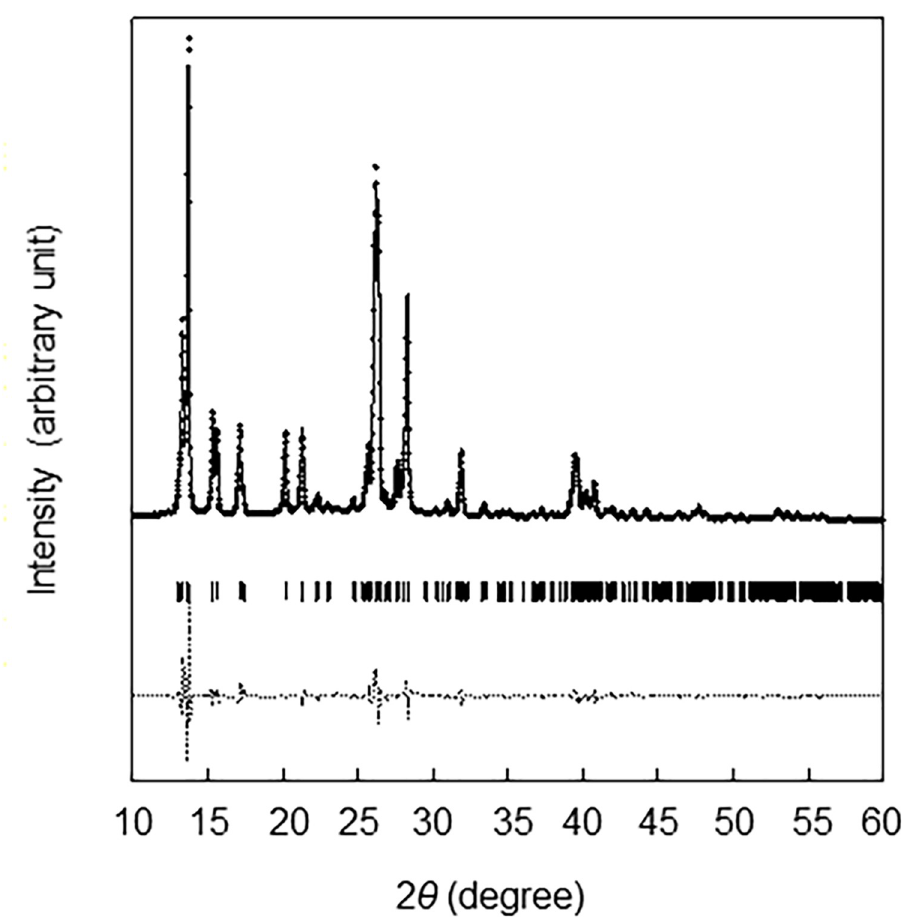
Fig 1. X-ray diffraction profile of the siderophore produced by C . cupreum . The closed black circles represent the measured intensity. The solid curve shows the calculated diffraction pattern using the best-fit parameters from Rietveld analysis. The peak positions calculated from the structure of C 14 H 10 O 8 (C2/ c ) are shown by ticks below the diffraction patterns. The dashed lines are the deviation between the measured and calculated intensities.